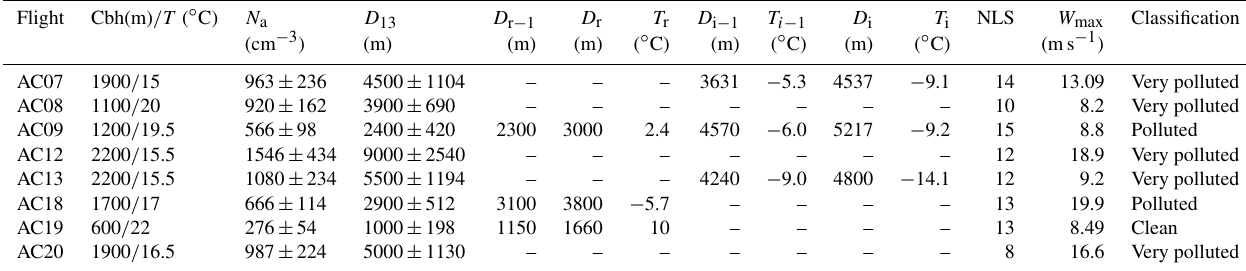
Table 3. Classification of each flight as a function of N a at cloud base. The values of cloud base height (Cbh) and temperature ( T ) , D 13 , D r and D i in meters, and temperatures in ◦ C are also shown for the convective cloud measurements of each flight. Additionally, information about the height of D r − 1 , D i − 1 , T r , T i , T i − 1 , NLP, and W max is also shown for each flight. The uncertainties of N a and D 13 estimates are described in Appendix